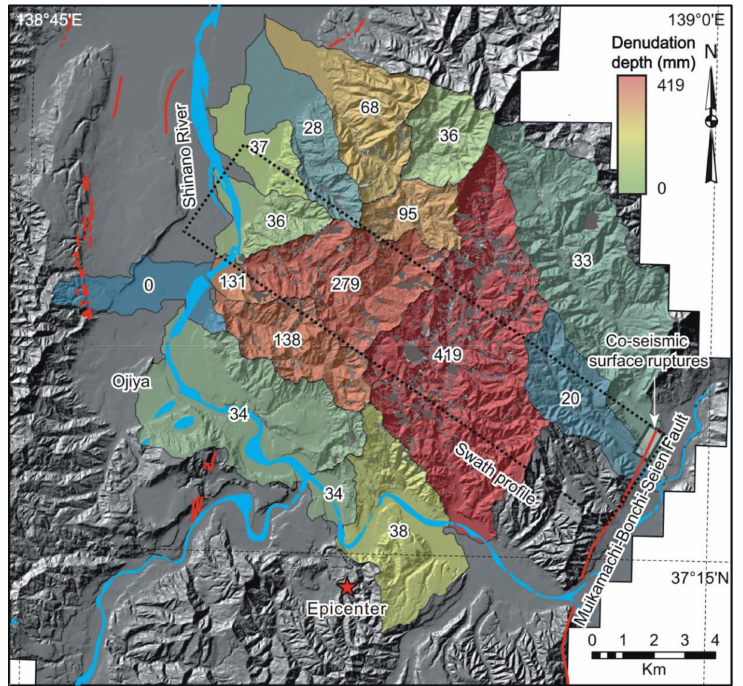
Figure 7. The distribution of catchment-scale average denudation. The denudation depths are obtained by averaging the total landslide volume by the area within each catchment.